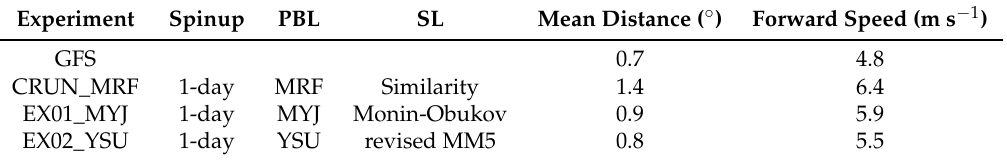
Figure 3. Domain configuration for the simulations of Hurricane Otto using WRF-ARW. The horizontal resolution is 27, 9 and 3 km for domains D01 (blue), D02 (black), and D03 (red). The grey line shows the storm track from the observations during the simulation period from 1200 UTC 23 November 2016 to 1200 UTC 25 November 2016. Table 1. Experiments carried out to study the intensification and trajectory of Hurricane Otto in the WRF-ARW using different planetary boundary layer (PBL) schemes. SST is not updated in the simulations. CRUN_MRF, EX01_MYJ, and EX02_YSU are: the control-run using the Medium Range Forecast (MRF), the Mellor-Yamada-Janjic (MYJ) and the Yonsei University (YSU) schemes, respectively, in conjunction with their respective surface layer parameterization (SLP). Comparison of storm track dispersion and forward speed between simulations and observations of Hurricane Otto. The observations are taken from Best Track database provided by Brown [3]. Observed forward speed was 4.7 m s − 1 . The simulations are started on 1200 UTC 22 November 2016 to allow 1-day spinup in the simulation. The analysis period is from 1200 UTC 23 November 2016 to 1200 UTC 25 November